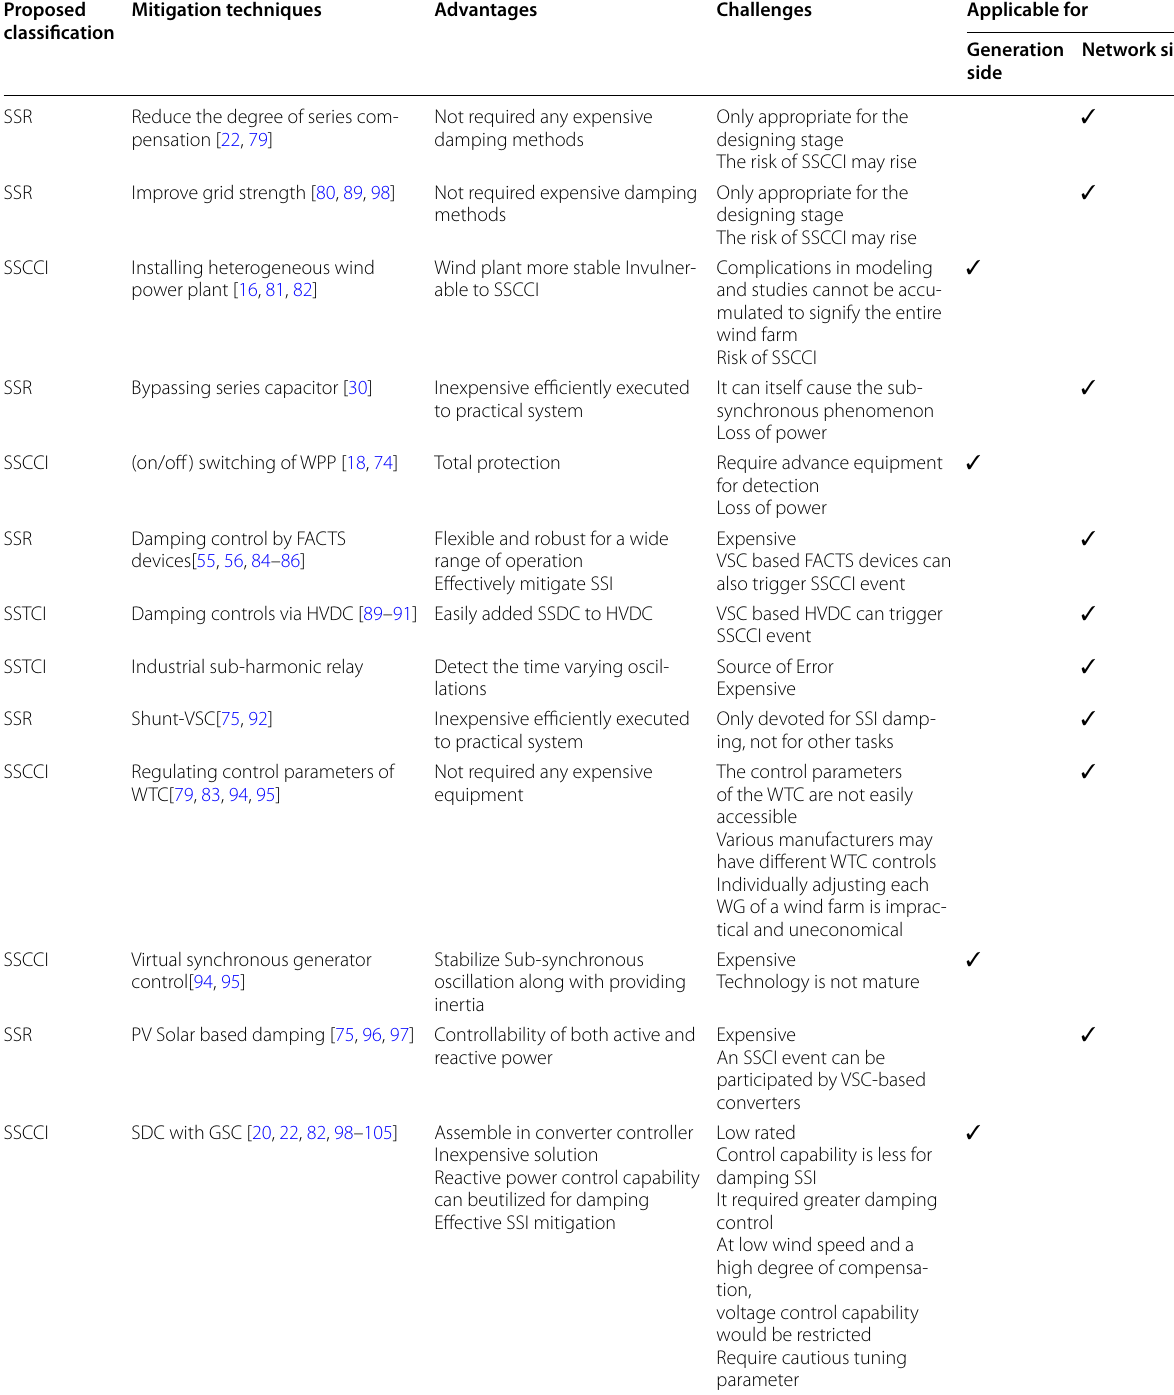
Table 4 Summarization of solutions techniques and challenges for SSI mitigation Proposed Mitigation classification